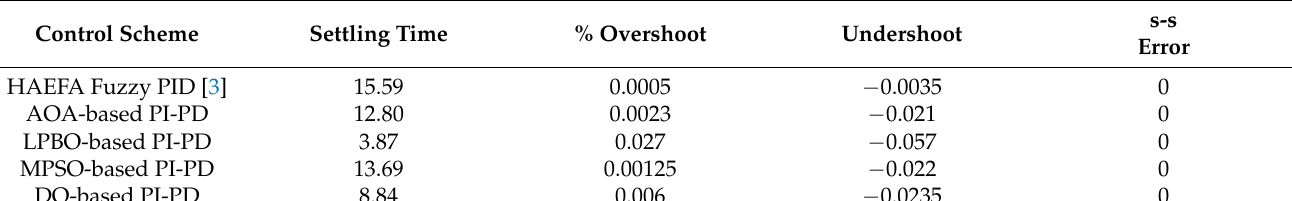
( b ) Figure 7. AVR responses in a two-area multi-source IPS. ( a ) V t1 ;( b ) V t2 .